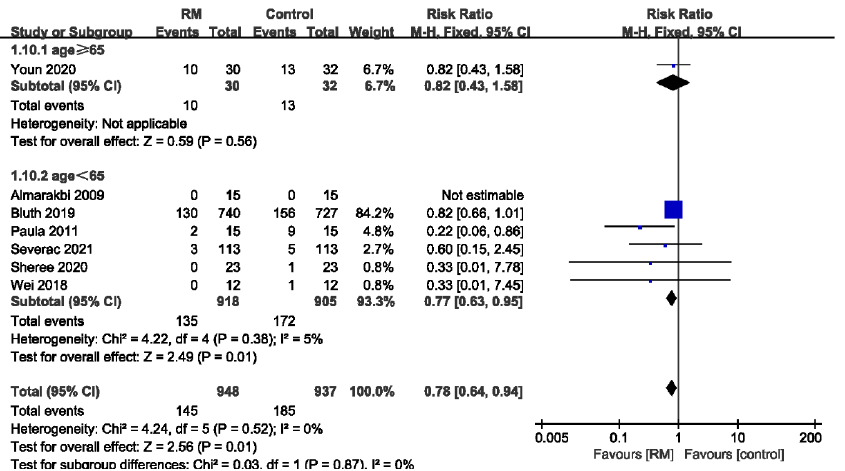
Figure 5. Forest plot for subgroup analysis of the incidence of PPCs between RM and control groups. Grouped by age: age ≥ 65 years, age < 65 years [16,17,26–28,30,32].